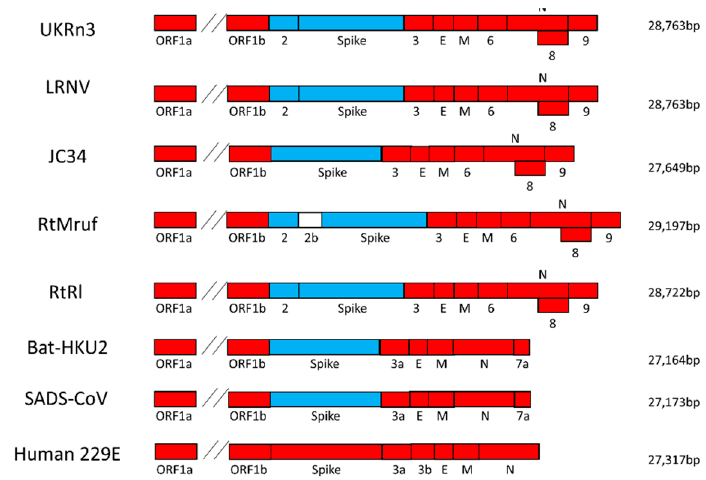
Figure 1. Genome organisation of rodent alphacoronaviruses. Schematic representation of the UK Rn 3 genome organisation along with those of other rodent alphacoronaviruses ( α -CoVs): Lucheng Rn CoV (LRNV), AcCoV-JC34, RtRl-CoV, RtMruf-CoV, and the related Bat-HKU2 and Swine acute diarrhoea syndrome coronaviruses (CoV) (SADS-CoV). Its genome organisation was similar to those of members of the genus Alphacoronavirus , with the characteristic 5’- ORF1ab - spike (S) - envelope (E) – membrane (M) - nucleocapsid (N) - 3’ gene order. The red colour represents genes that belong to the genus Alphacoronavirus , whereas light blue denotes genes that belong to the genus Betacoronavirus , indicative of recombination. The Human 229E genome represents a typical alpha-CoV genome organisation.